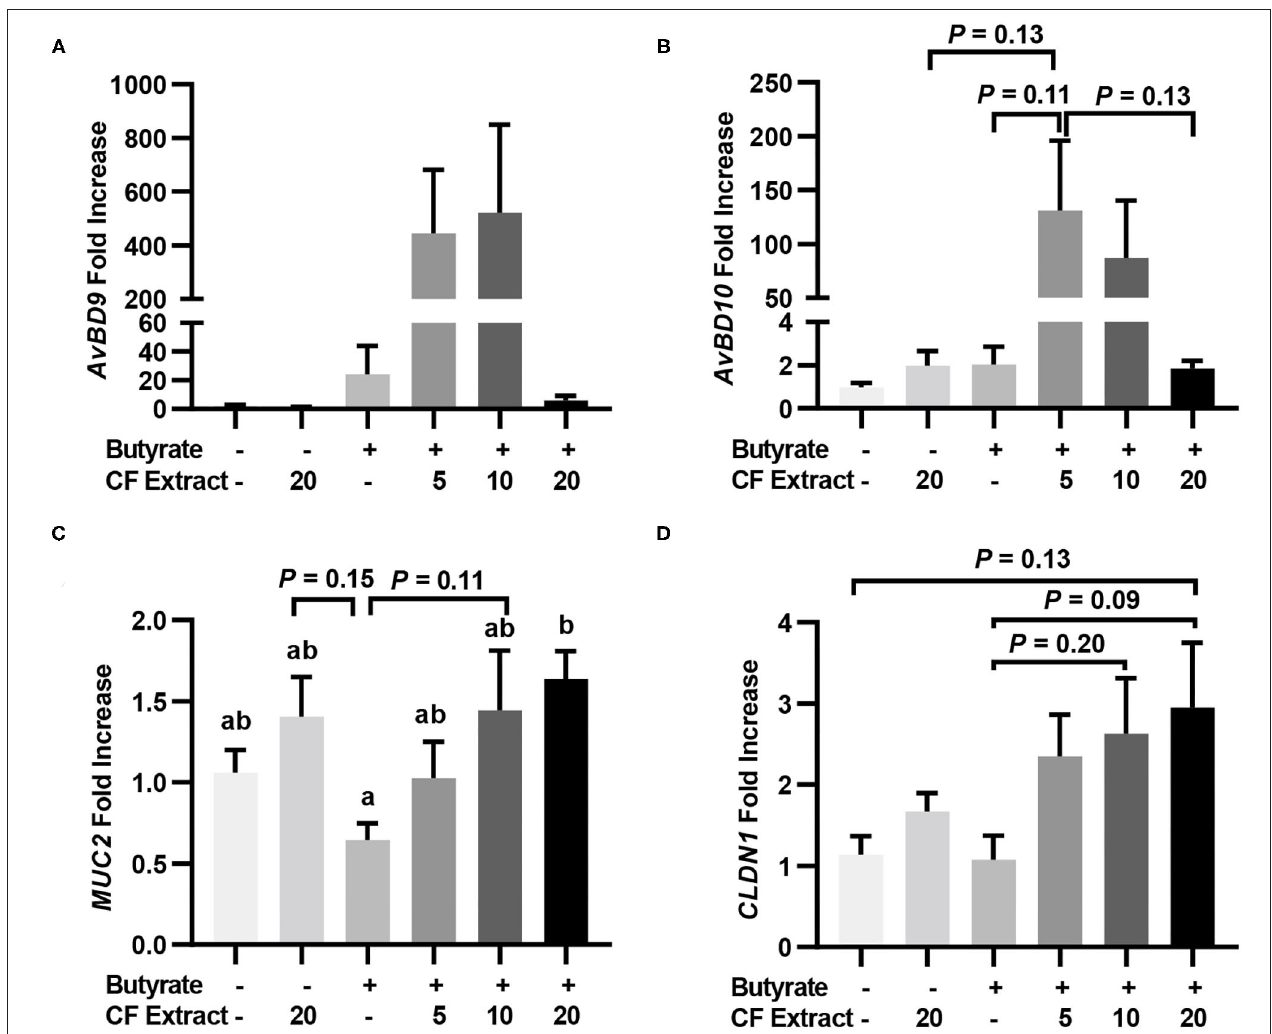
FIGURE 3 | Induction of HDP and barrier function genes by butyrate and FSK in the jejunum of chickens. Five-day-old broiler chicks were fed a basal diet supplemented with or without 1 g/kg sodium butyrate or different concentrations of 10% FSK-containing Coleus forskohlii plant extract individually or in combination for 48h. A segment of the jejunum was collected and subjected to RT-qPCR analysis of gene expressions of AvBD9 (A) , AvBD10 (B) , MUC2 (C) , and CLDN1 (D) . Results are shown as means ± SEM of eight chickens per group. Statistical significance ( P < 0.05), denoted by non-common letters, was determined using one-way ANOVA and post-hoc Tukey’s test. Treatments with P < 0.20 were also indicated to show a